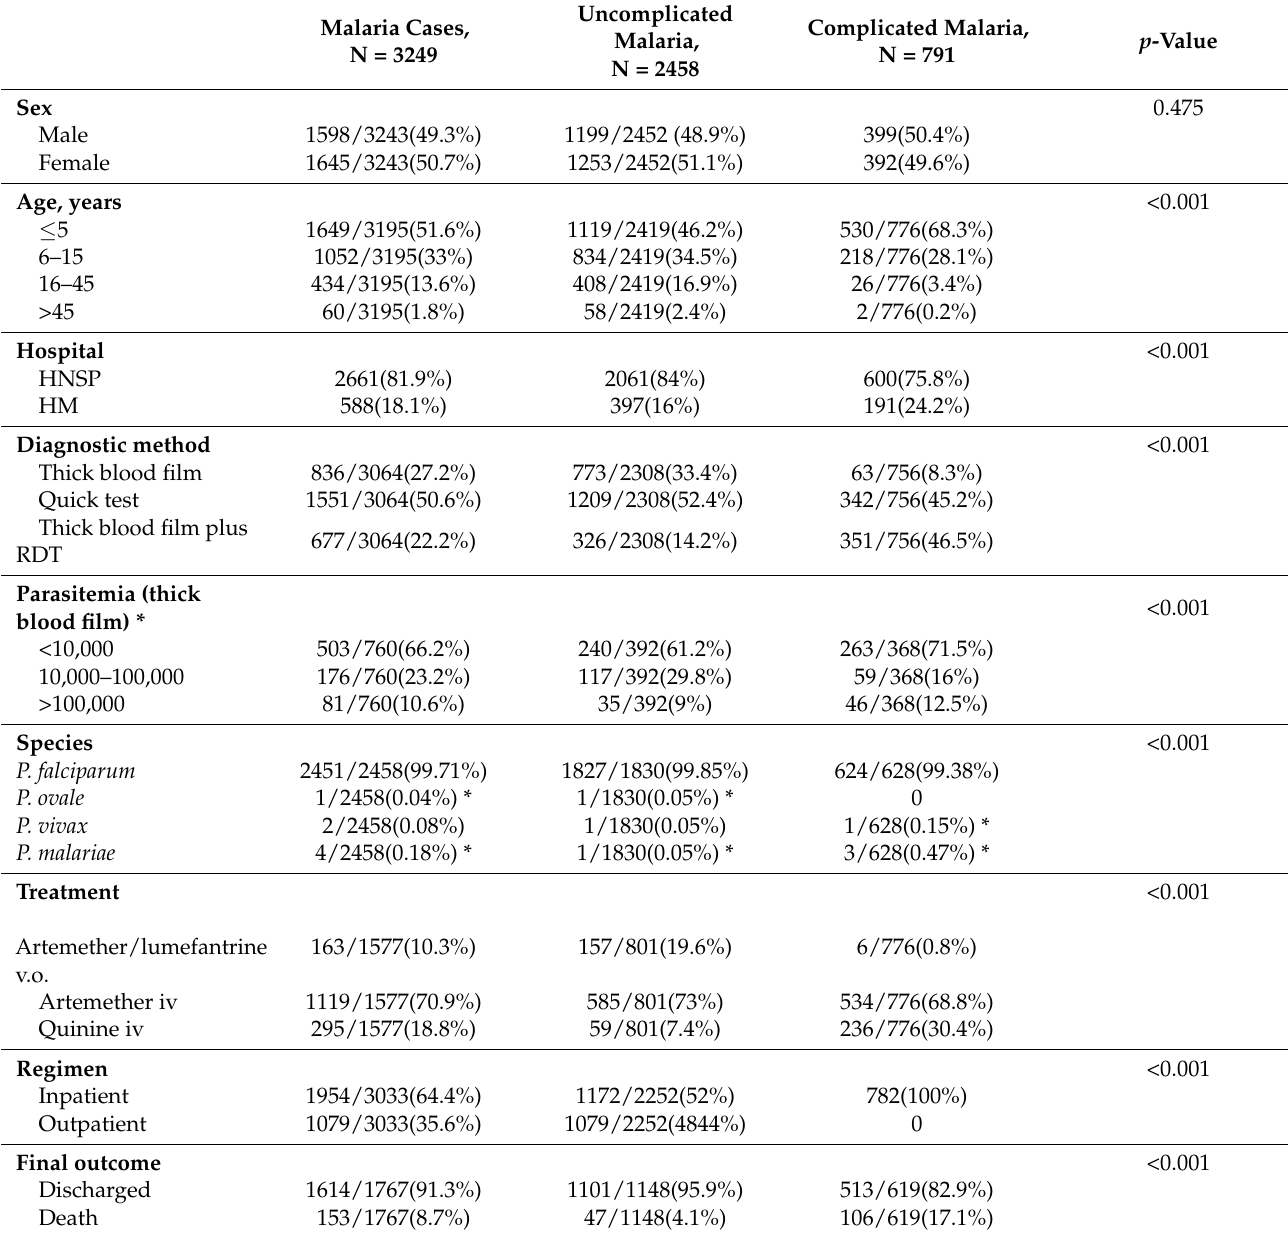
Table 1. Demographic characteristics of patients diagnosed with malaria in Cubal, Angola, from 2014 to